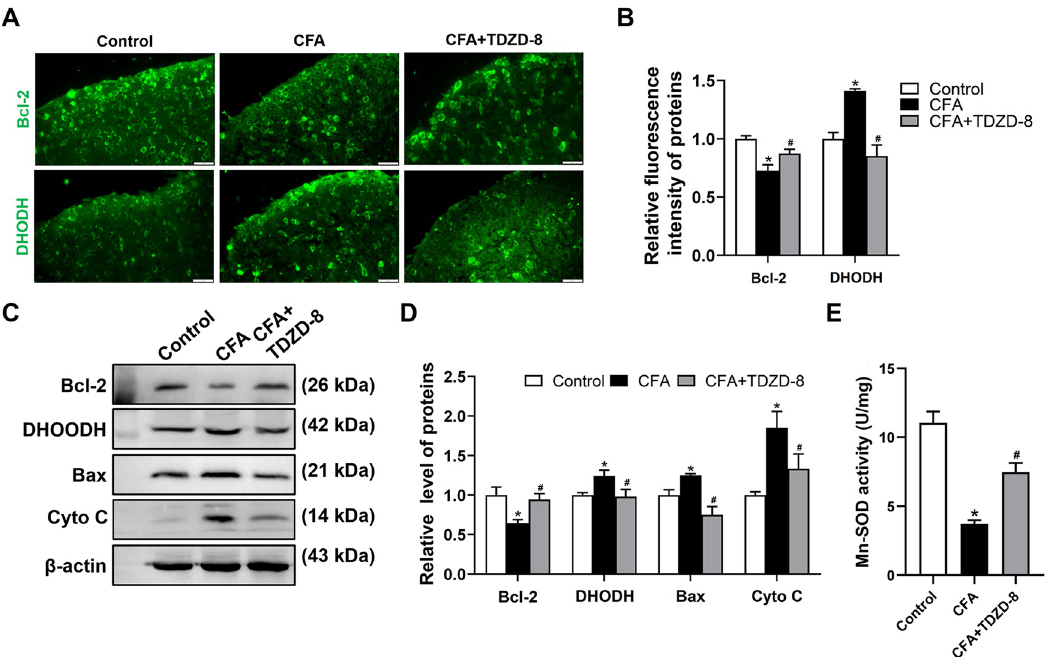
Fig 4. Effect of TDZD-8 treatment on oxidative stress level. (A) Immunofluorescence staining of Bcl-2 and DHODH on spinal cord sections. Scale bar = 20 μ m. (B) Quantitative analysis of Bcl-2 and DHODH fluorescence intensity. Data are expressed as the mean ± SD (n = 3). (C, D) Western blot analysis (C) and relative grey values (D) of expression levels of Bcl-2 and DHODH in spinal cord. β -actin was used as a loading control. (E) Changes in Mn-SOD activity detected by Mn-SOD Assay Kit. Data were expressed as the mean ± SD (n = 3). * P < 0.05 vs . control group, # P < 0.05 vs . CFA group.